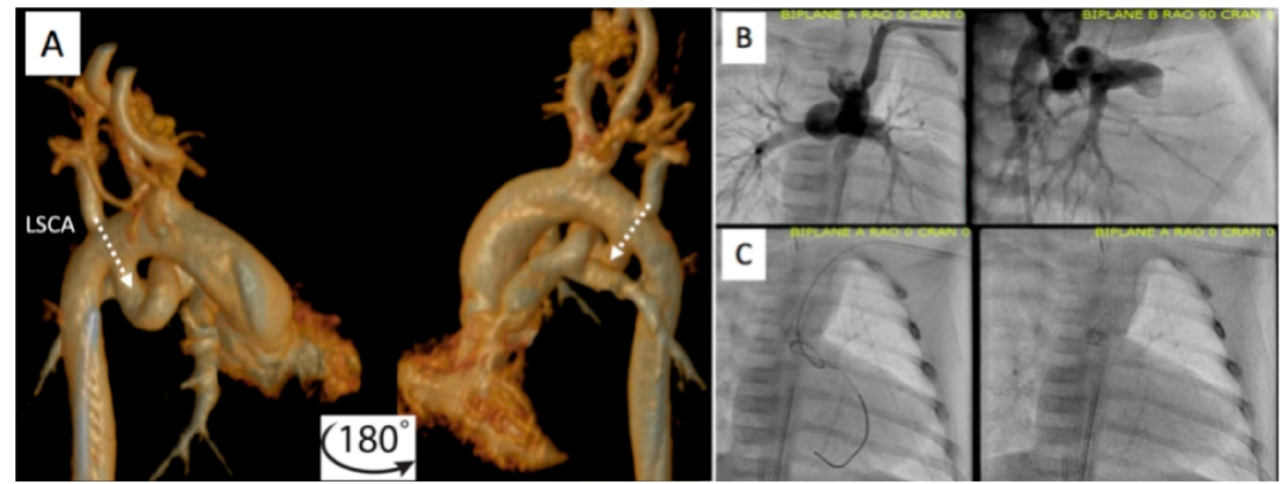
Figure 9. Additional example of pre-procedural CT imaging ( A ) aiding with access site selection for successful PDA stenting ( B , C ) via the left axillary artery (LAA) to the left subclavian artery (LSCA). Revised from ref [9].